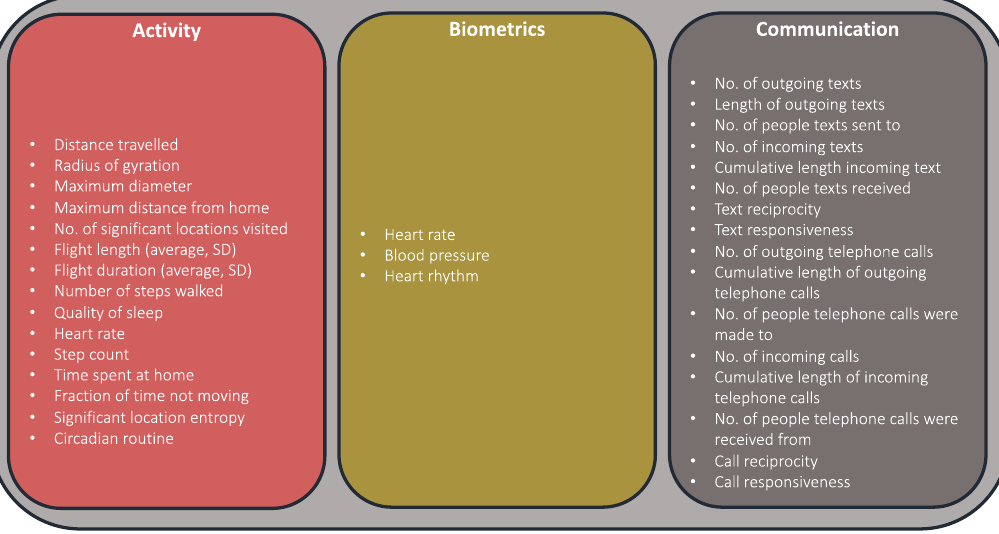
Figure 7. The “Activity-Biometrics-Communication” Framework of Activity, Biometric, and Communications data points captured using Personal Digital Devices. This does not include capture of patient-reported outcome measurements (PROMs) and other survey questions via Smartphone applications/other